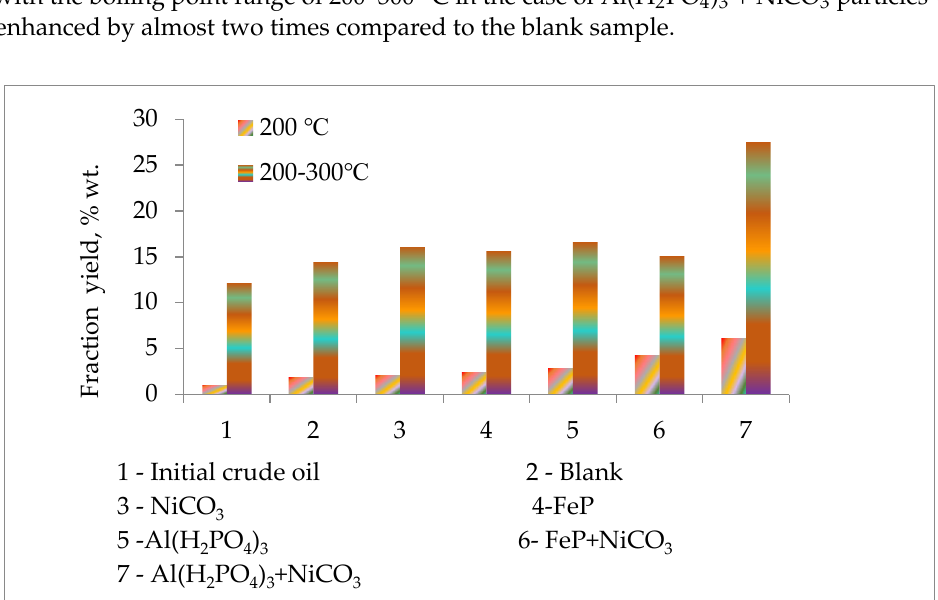
Figure 4. The content of resins and asphaltenes before and after thermolysis. The upgrading efficiency of heavy oil can be followed by the oil’s boiling point as well (Table 1). The presence of both Al(H 2 PO 4 ) 3 + NiCO 3 and FeP + NiCO 3 catalytic com- plexes reduced the crude oil boiling point from 170 °C to 75 °C due to the formation of